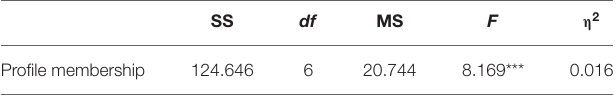
TABLE 8 | ANCOVA result comparing neuroticism among